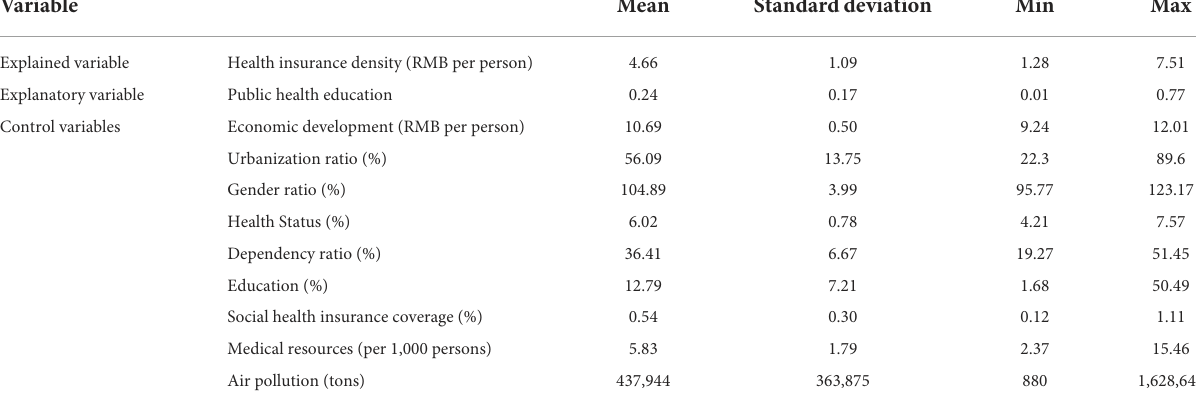
TABLE 2 Descriptive statistics of